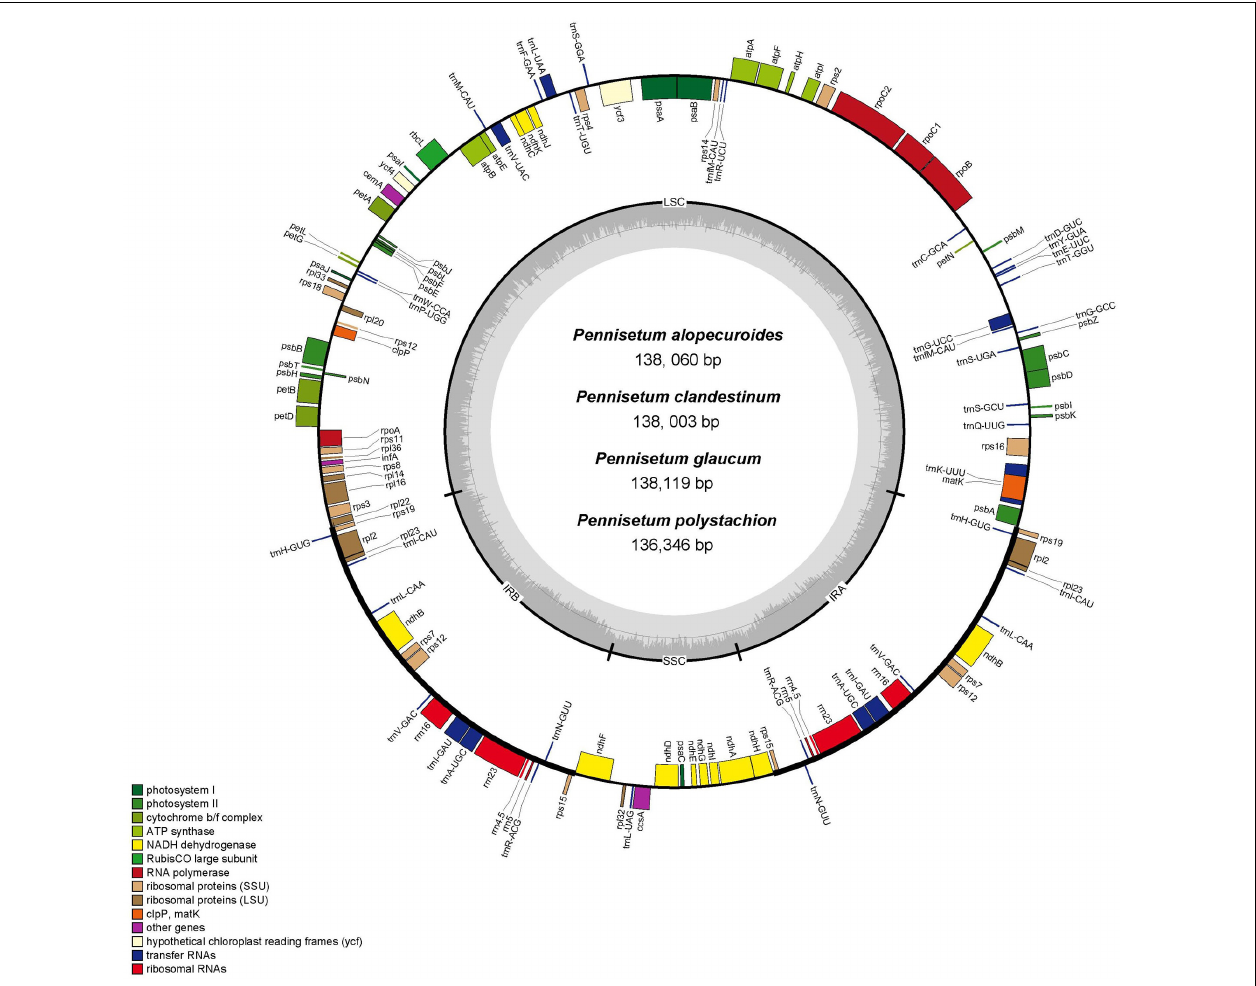
FIGURE 1 | Gene map of the complete chloroplast genome of four Pennisetum species. Genes inside the circle are transcribed clockwise, and those outside are transcribed counterclockwise. The different colors of the blocks represent different functional groups. The darker gray color of the inner circle corresponds to the GC content, and the lighter gray color corresponds to the AT